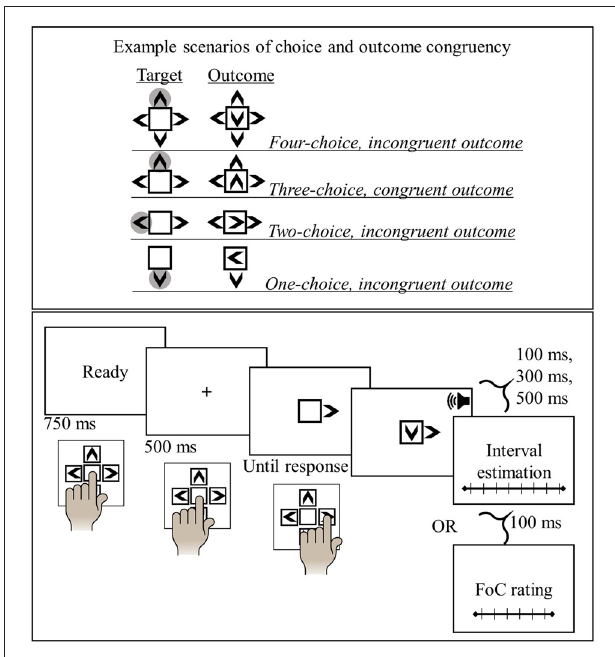
FIGURE 1 | Illustration of the experimental conditions (upper panel) and procedure (lower panel) in interval estimation and feeling of control (FoC) tasks.